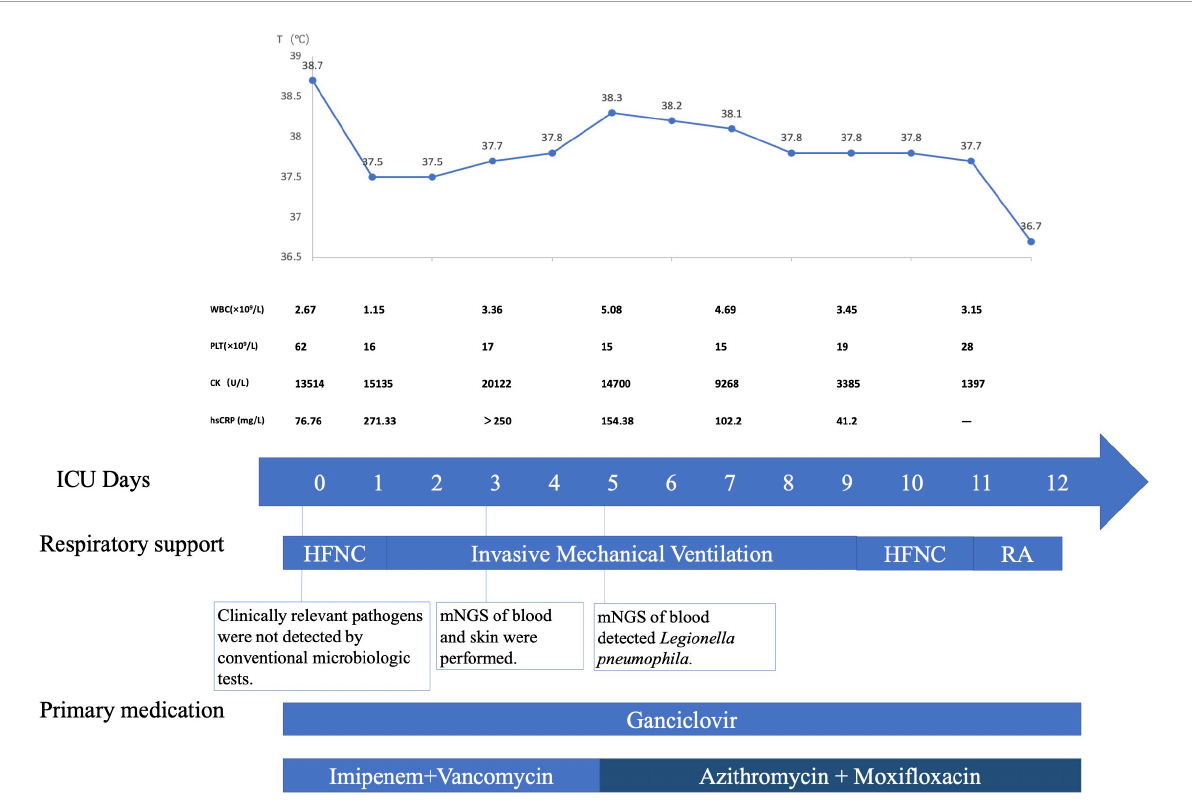
FIGURE3 Timeline of the patient with disseminated Legionnaires’ disease. The patient was transferred into MICU on May 12, 2021, which was ICU Day 0. Major events during the course of the patient’s illness are indicated in the graph. The upper graph shows the body-temperature curve (blue line). Laboratory values obtained and primary medications administered during the patient’s ICU hospitalization are shown below. HFNC denotes high-flow nasal cannula, MICU medical intensive care unit, RA room air, mNGS metagenome Next-Generation